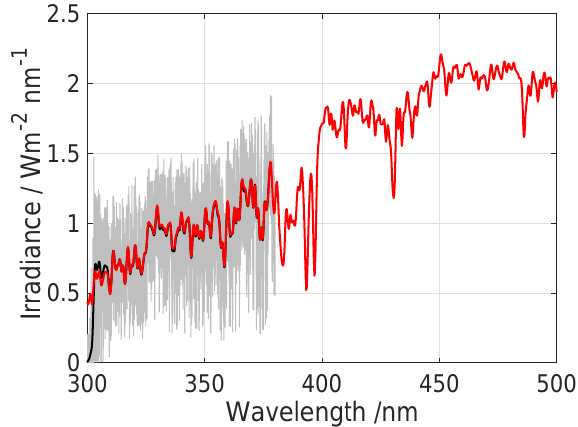
Figure 3. Solar spectra obtained from direct irradiance measure- ments with QASUME (red curve) and the FTS (grey curve). The black curve is calculated from convolving the high-resolution spec- trum of the FTS with the QASUME slit